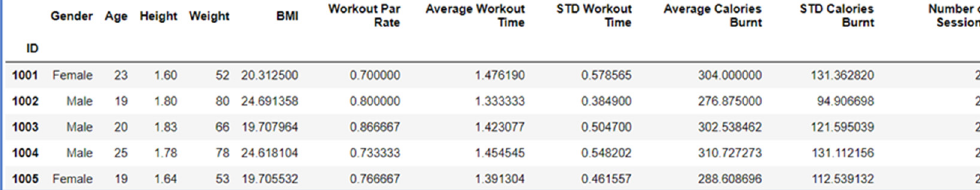
Figure 4. Sample of step count dataset.